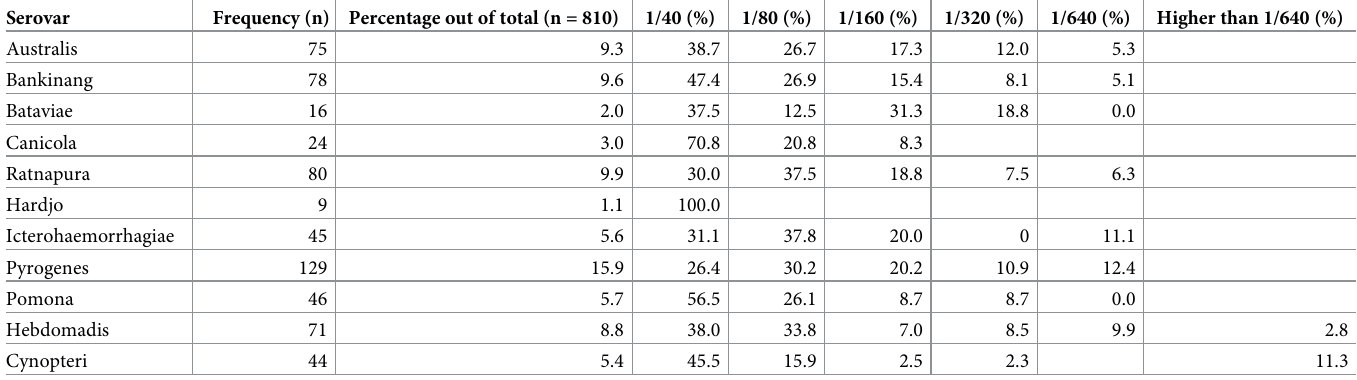
Table 2. Serovar distribution and observed titers in the study population. Numbers under individual titres- number positive for titer/total number positive for that serovar, as percentage. Serovar Frequency (n) Percentage out of total (n =